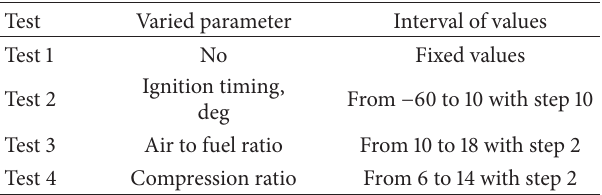
Table 3: Varied engine operating parameters.